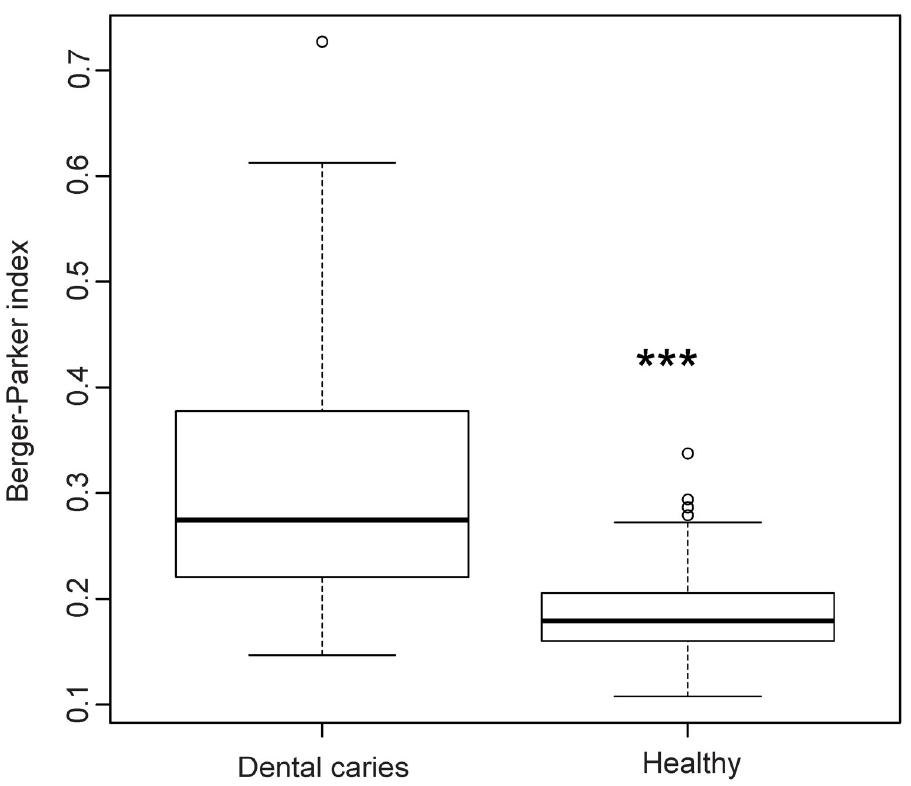
Fig 6. Microbial dominance. Boxplot of the Berger-Parker index evaluating the effect of group assignment on microbial dominance.